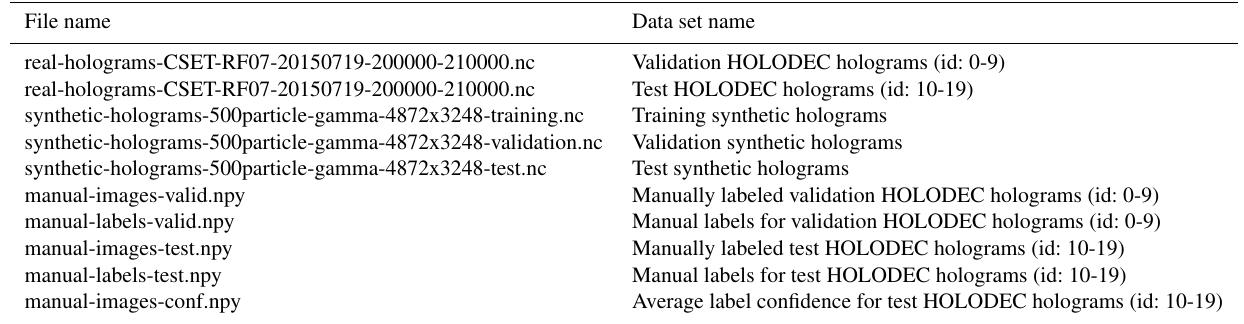
Table A2. The HOLODEC and synthetic data sets are matched with the notation used here for HOLODEC and synthetic holograms. File name